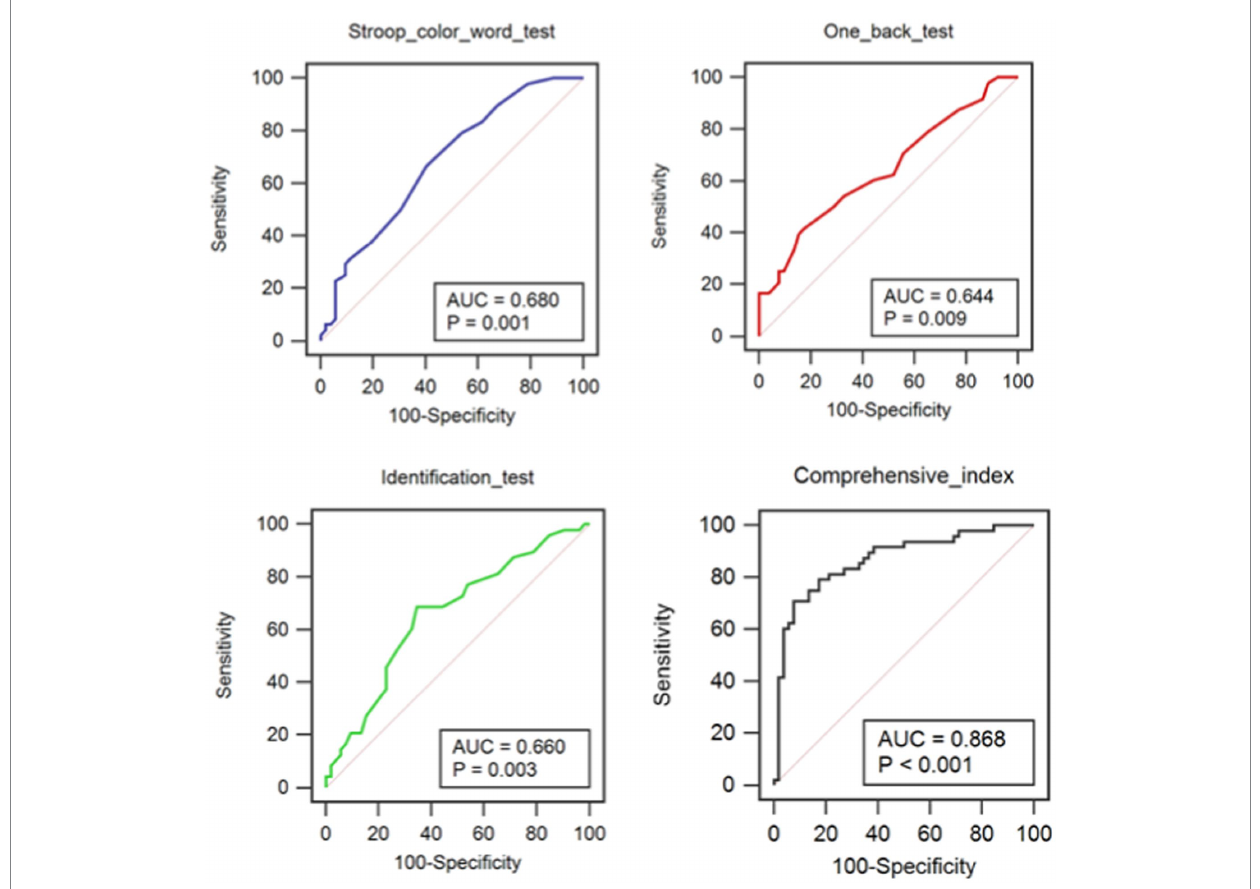
FIGURE 2 ROC curves of Stroop color-word test, identification test and comprehensive